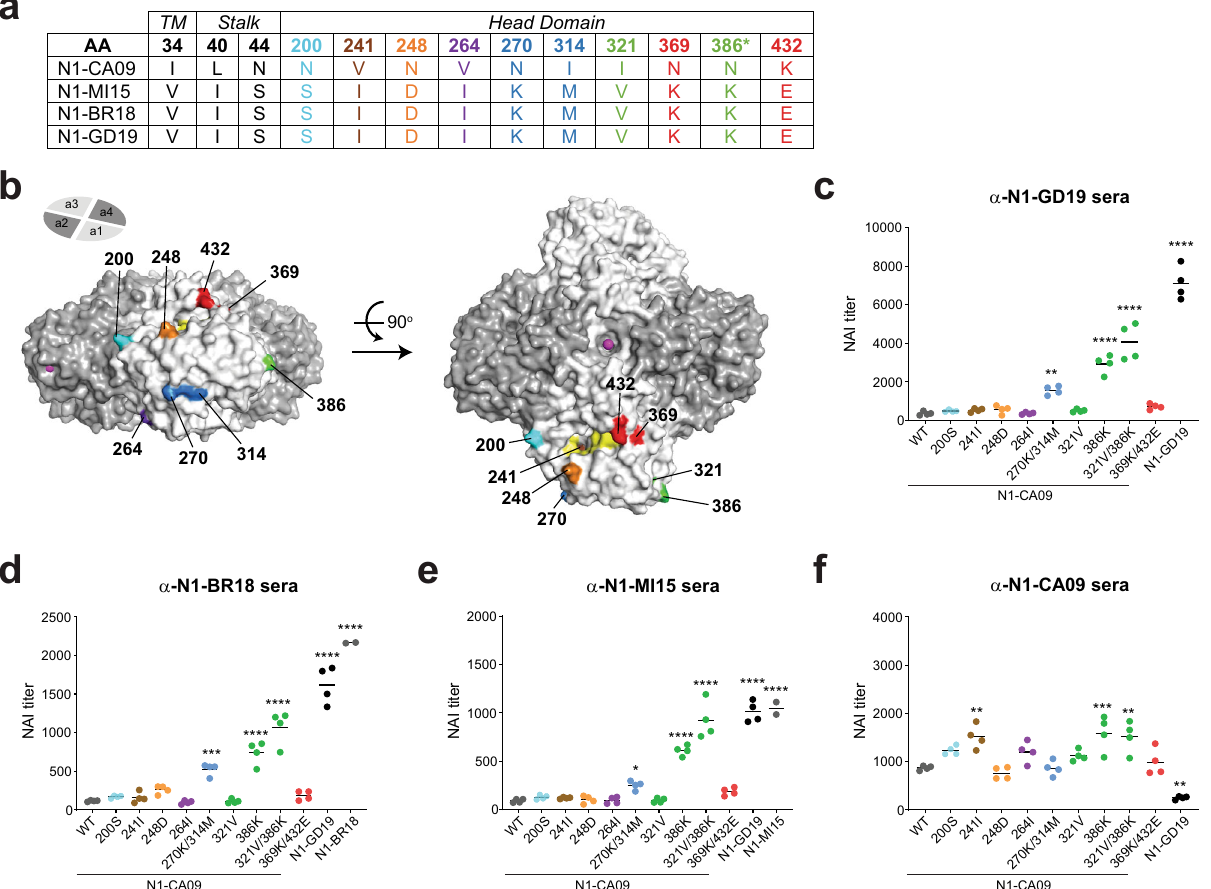
Fig. 5 Head substitutions contribute to the antigenic change in NAs from recent H1N1 vaccine strains. a Chart displaying the amino acid positions where N1-GD19, N1-BR18 and N1-MI15 all differ from N1-CA09 by the same amino acid. Positions that were not analysed experimentally are shown in black. The asterisk indicates the position where N1-CA09 has an N-linked glycosylation site. b N1 head domain structure (PDB ID: 3NSS) 54 showing the positions of the residues that are unique in N1-CA09 on a single NA monomer. Active site residues (yellow) and Ca 2 + ions (pink) are also depicted. Side (left) and top (right) views of the NA tetramer were generated using Pymol. c – f Graphs displaying the NAI titers for the indicated NAs that were determined using ferret sera against ( c ) N1-GD19, ( d ) N1-BR18, ( e ) N1-MI15, and ( f ) N1- CA09. NAI measurements were made in duplicate in two independent runs using PR8 single gene reassortant viruses carrying the indicated NAs. N1-BR18 and N1-MI15 controls were run once in duplicate. P values were determined using a one-way ANOVA Dunnett ’ s multiple comparison test with a 95% CI and N1-CA09 as the comparator. ** P ≤ 0.01; *** P ≤ 0.001; **** P ≤ 0.0001. Source data for ( c – f ) are provided in the source data fi